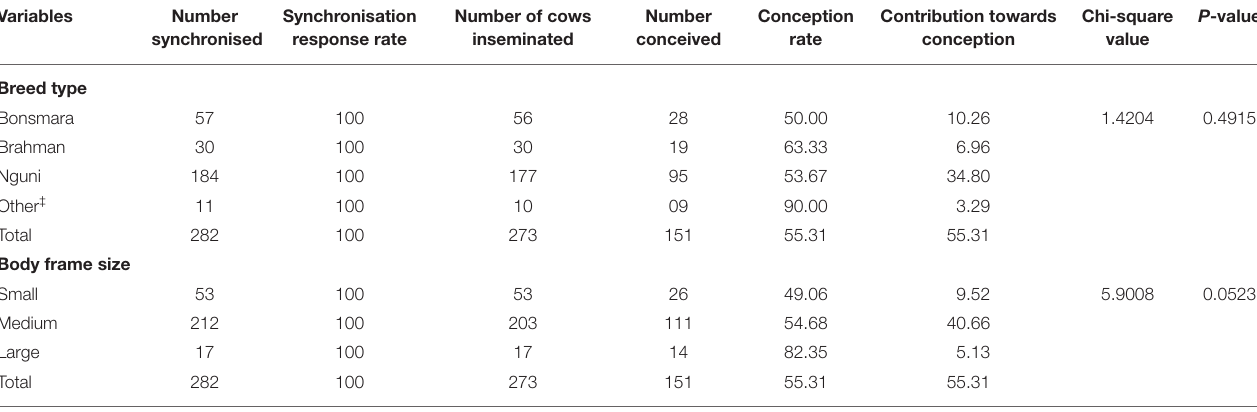
TABLE 2 | Effect of breed and body frame size on synchronisation response and conception rate of cows under communal and emerging farming systems. Variables Number Synchronisation synchronised response rate